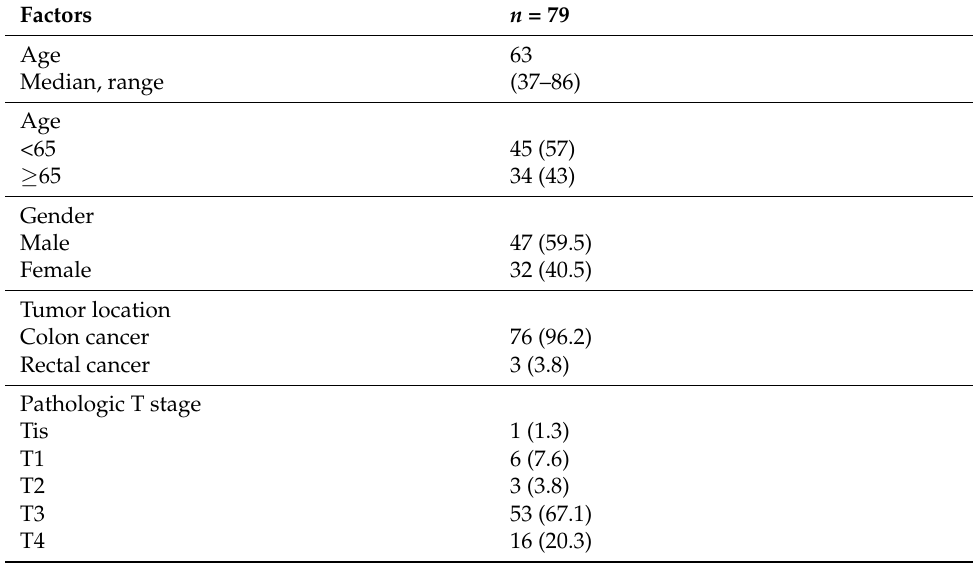
Table 1. Patient